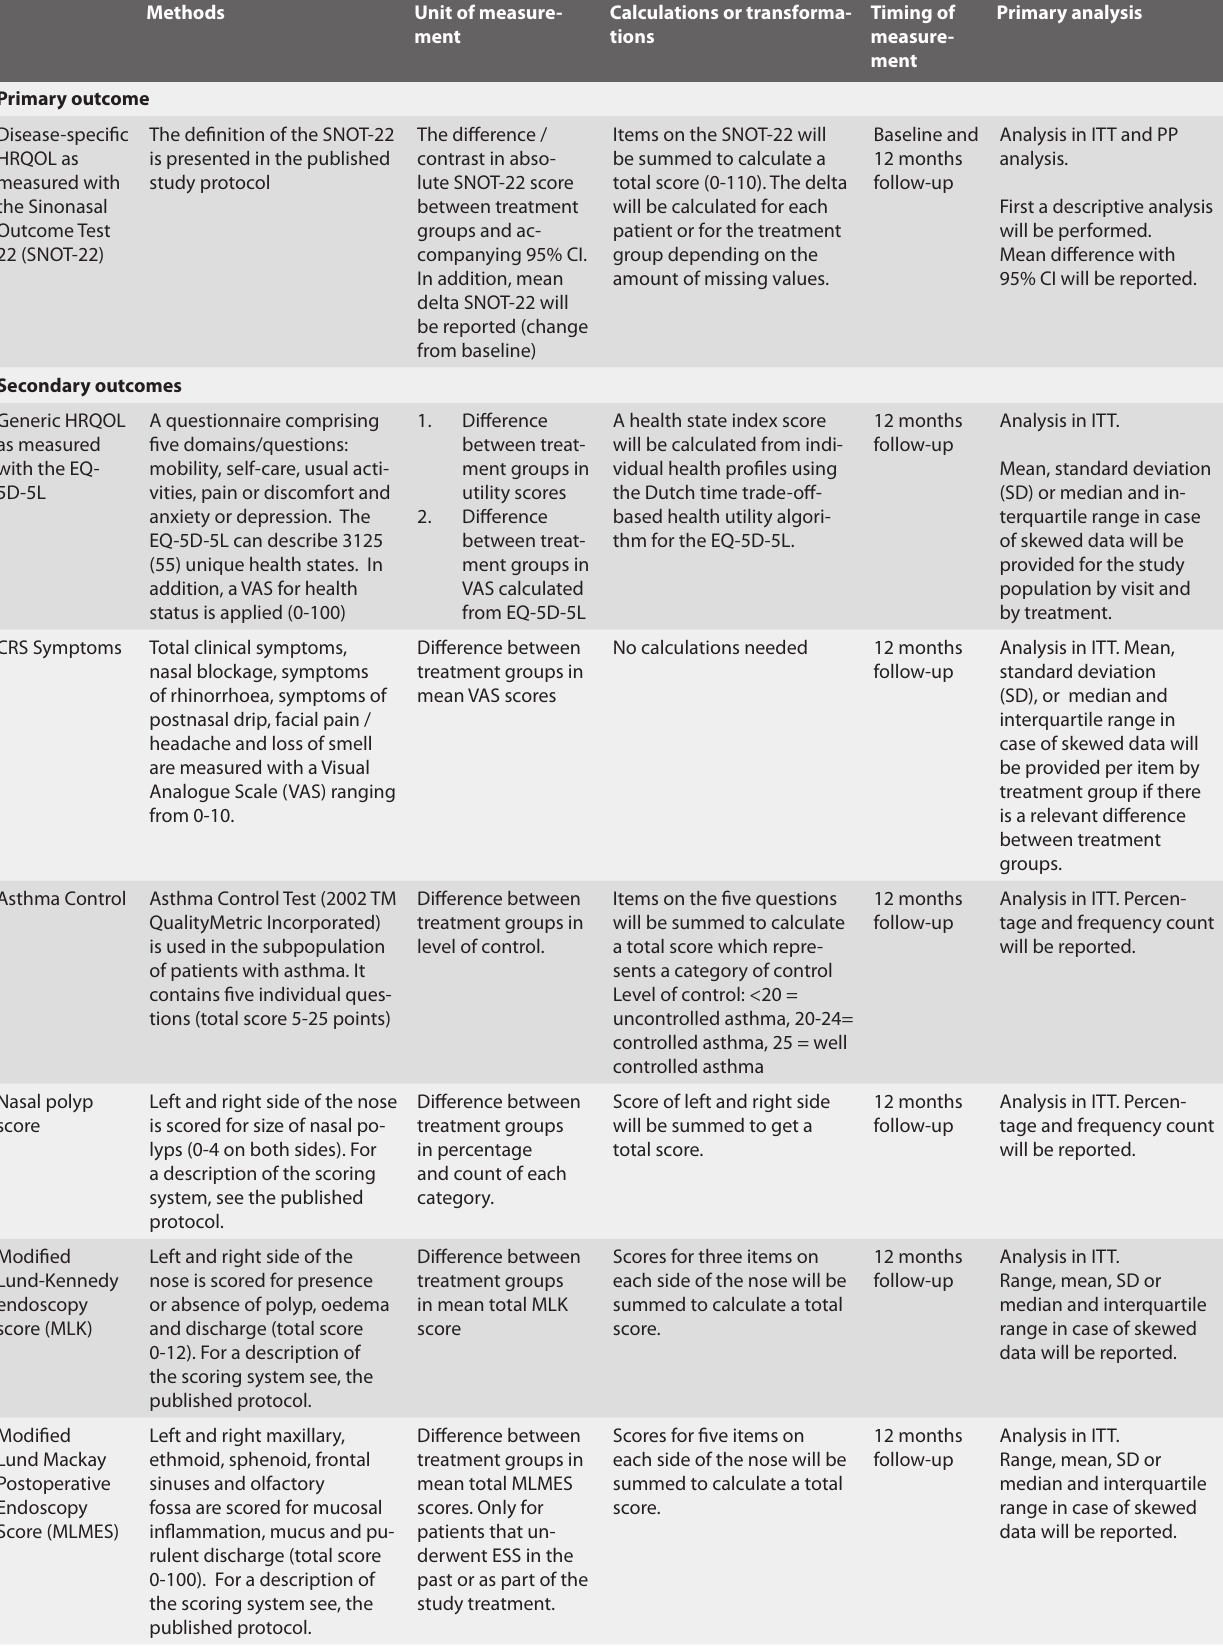
Table 2. The analysis of primary and secondary